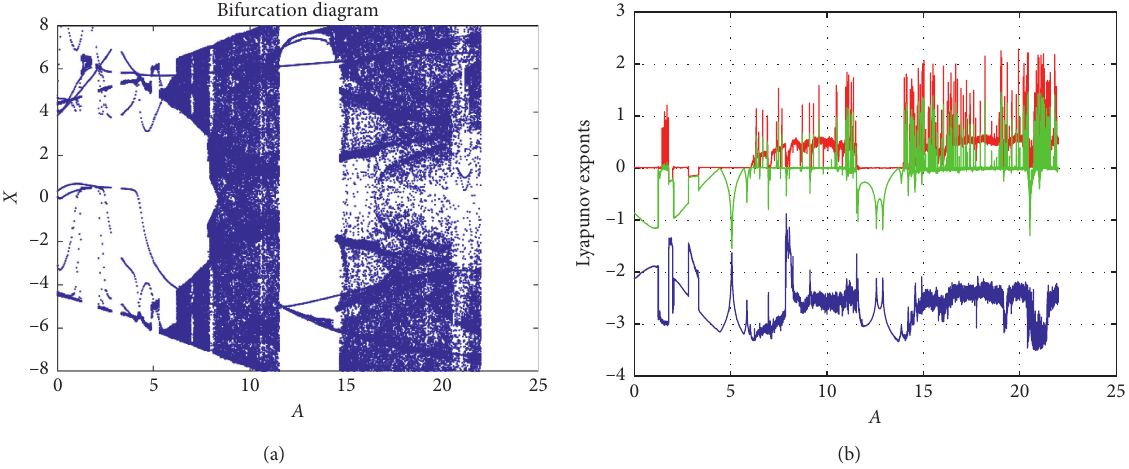
Figure 4: (a) The bifurcation diagram of A. (b) Spectrum of Lyapunov exponents changing A from 0 to 22.